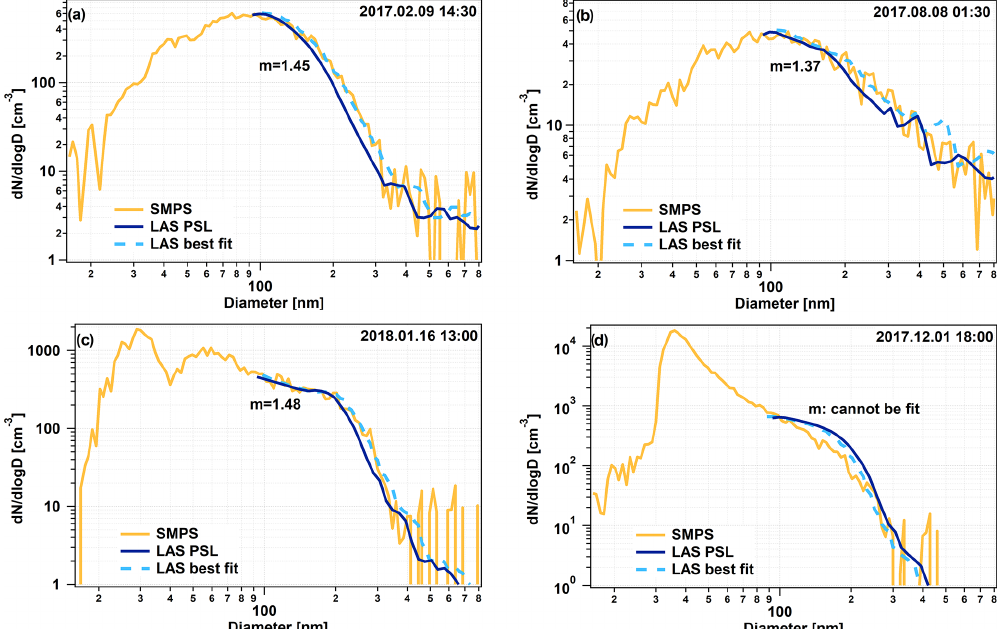
Figure 4. Four examples of the refractive index fit performance. The orange line shows the measured SMPS number size distribution, whereas the blue lines (dark: PSL calibrated; light and dashed: best fit) show the LAS number size